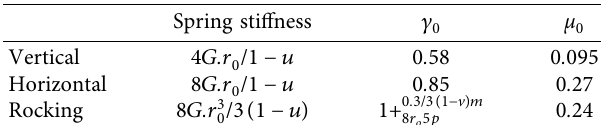
Figure 2: Configuration of viscous dampers [35]. Table 1: Basic information of studied buildings.